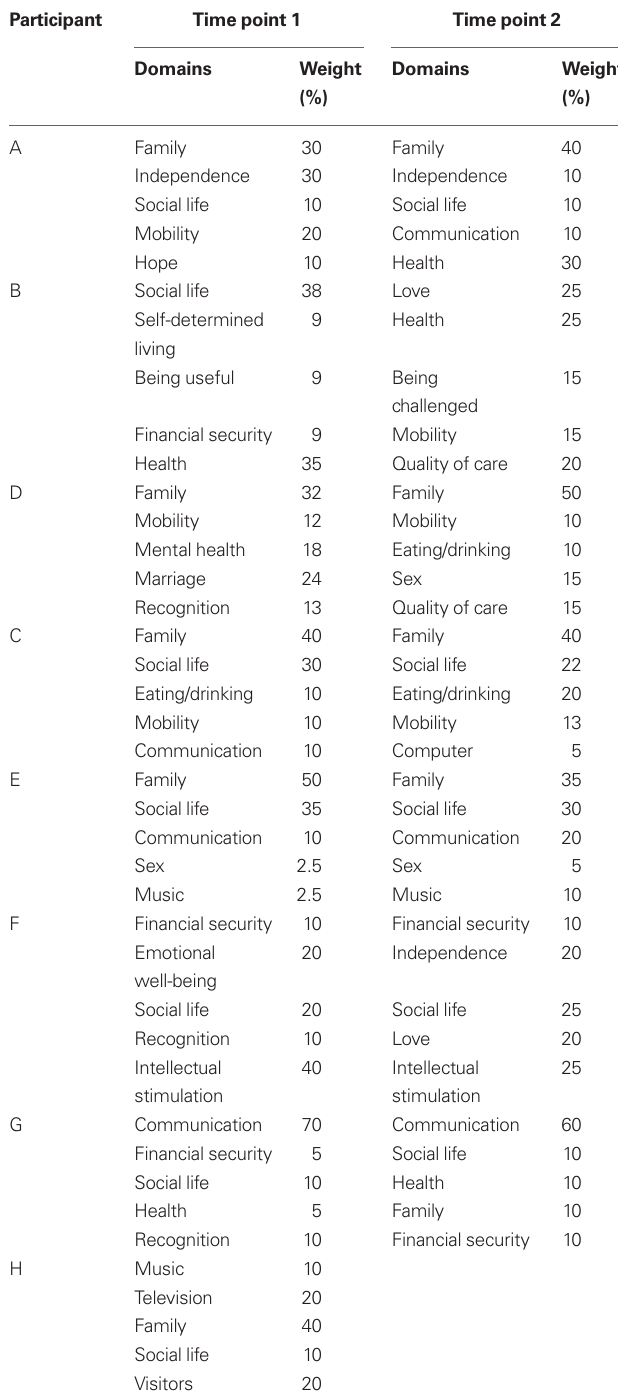
Table 4 | Overview of the domains that patients indicated as determinants of their QoL at time point 1 (T1) and time point 2 (T2). It can be seen that some domains listed at T1 were no longer important at T2, and new domains were added at T2. Additionally, the weights of domains, which indicate how important these domains were for the overall QoL of the participants, changed from T1 to T2. Both, the exchange of domains and the change in weight indicate response shifts (Sprangers and Schwartz, 1999) as disease progressed. The QoL of participant H was only assessed